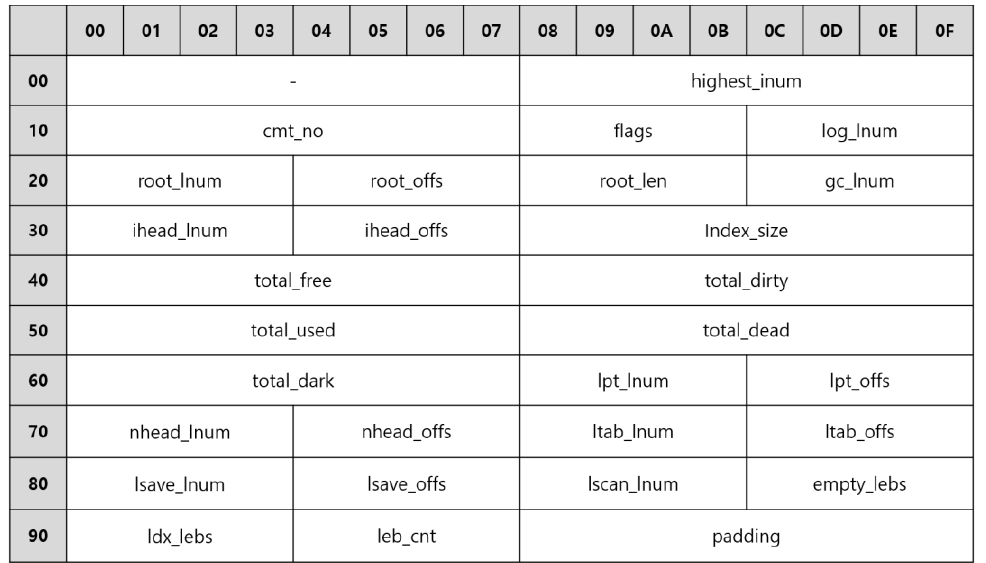
Figure 14. UBIFS master node in form of hex value.